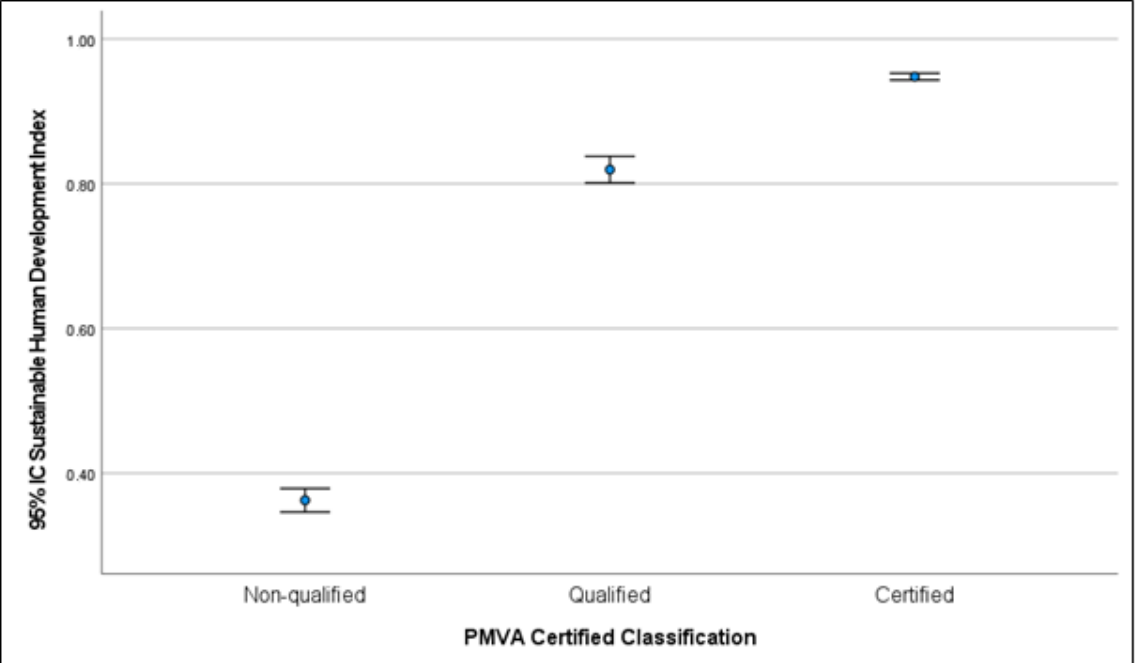
14 of 26 Table 6. Pairwise comparisons of the PMVA classification. Sample 1 vs. Sample 2